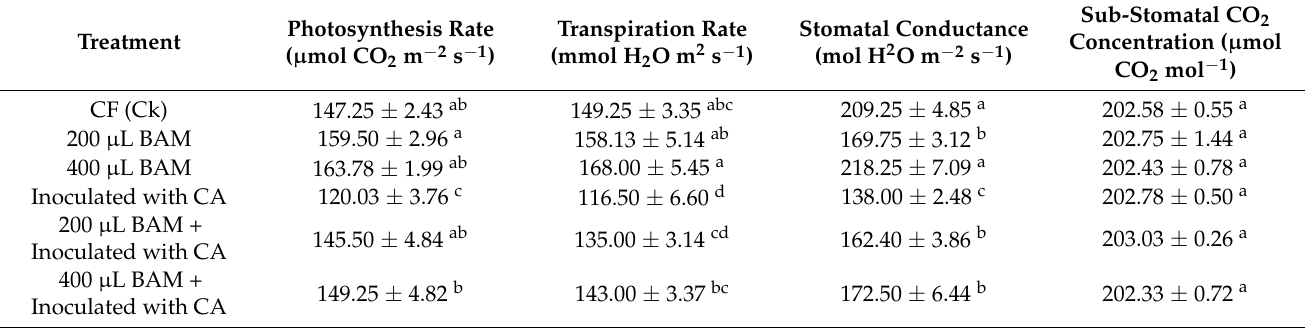
dechola ). The results are shown in Table 5. Table 5. Effects of BAM strain on the physiological parameters; all the values are the comparison of mean ± SE.